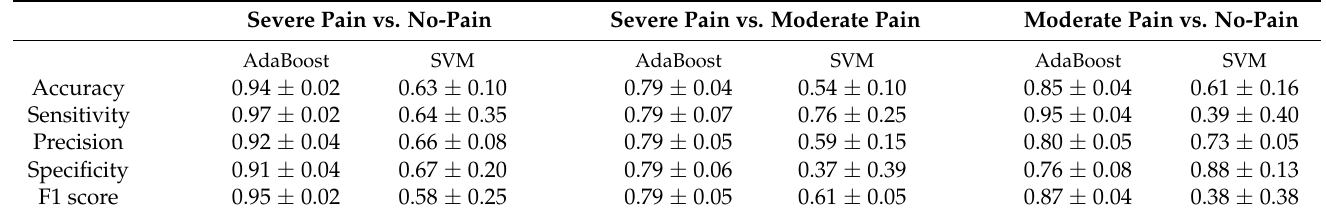
Table 1. Binary classification results of 10-fold cross-validation.